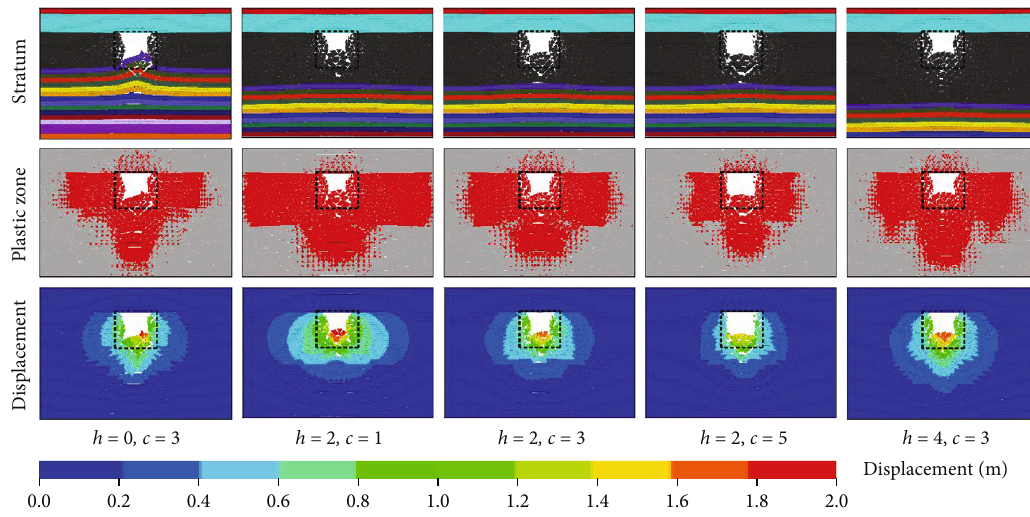
Figure 14: Simulation results of surrounding rock deformation of the roadway with retained bottom coal.